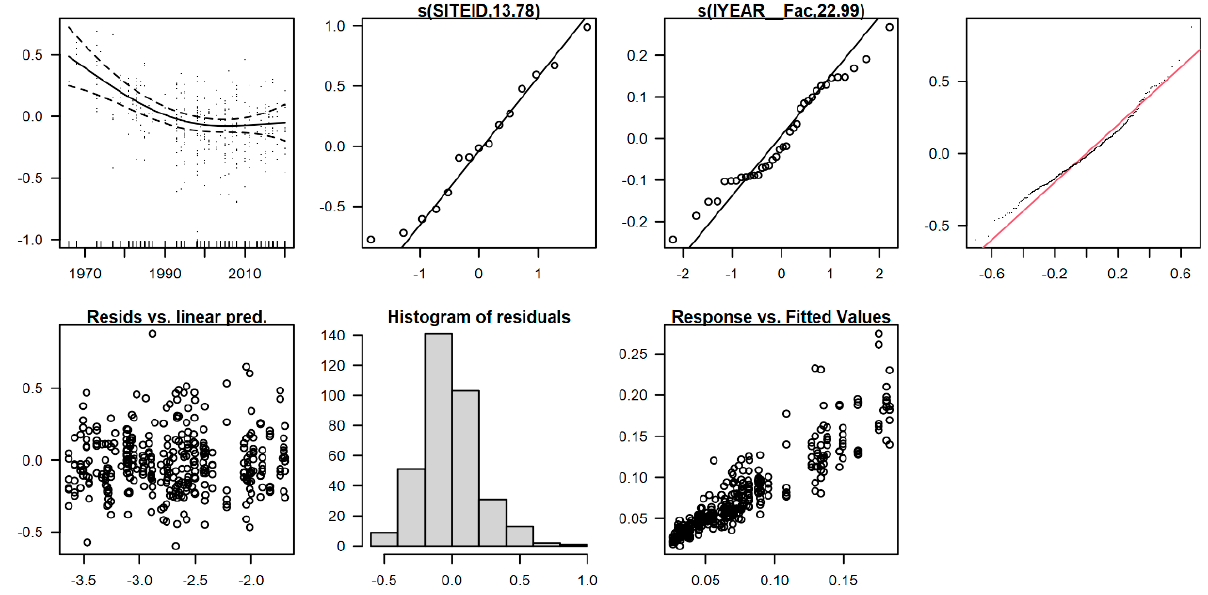
Figure A2. Example of graphical residual analysis (normality; homogeneity) of the selected generalized additive mixed model (GAMM) for the base saturation at unlimed plots in a 0–30 cm soil depth.